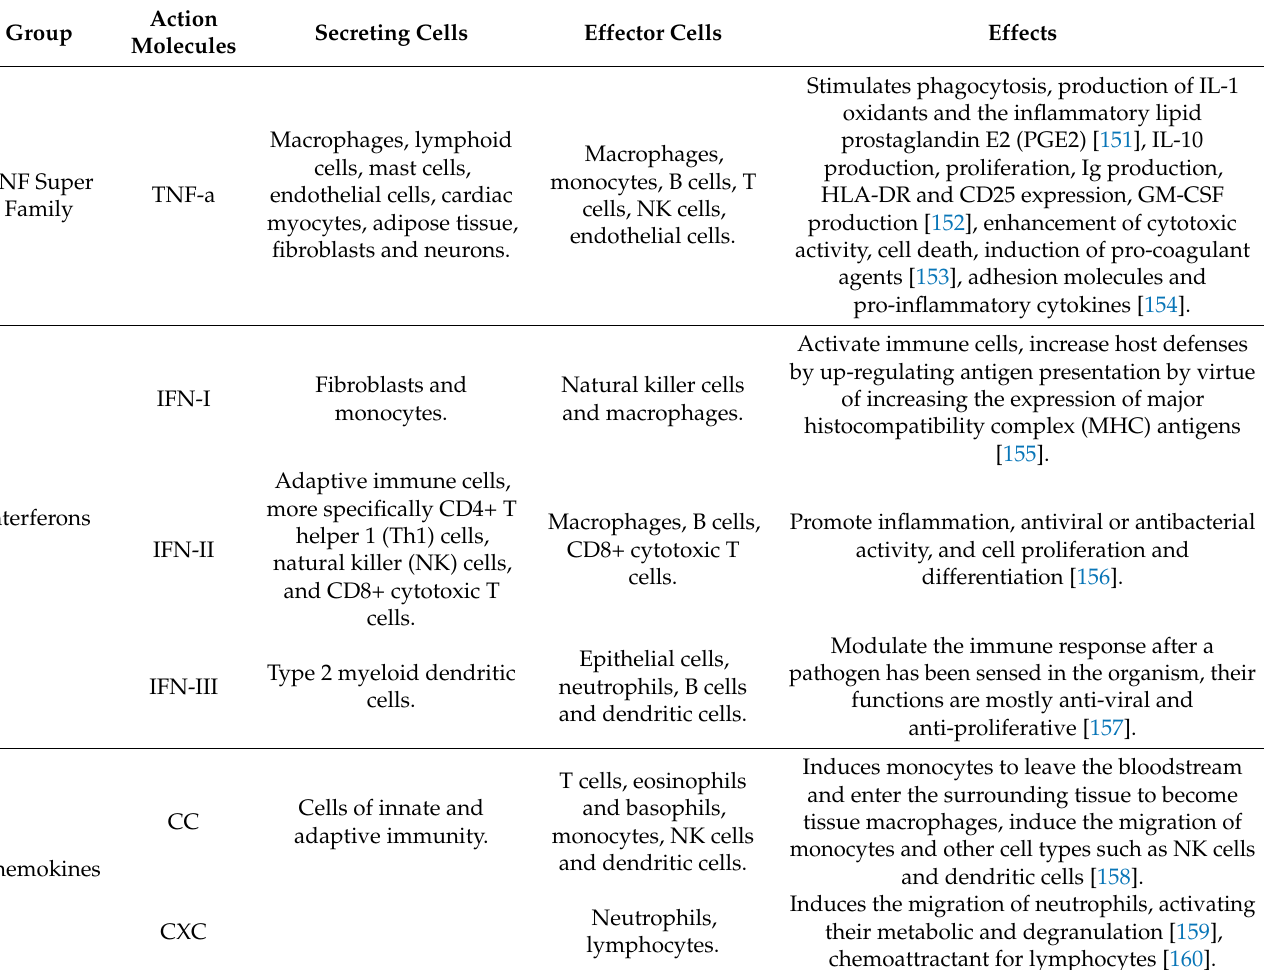
Table 1. The main effects of the described